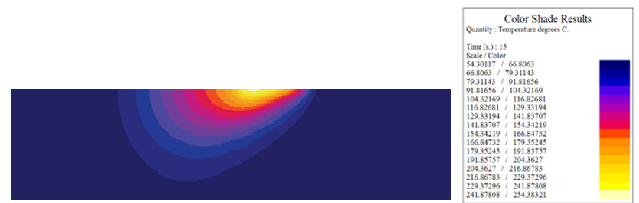
Figure 14. Temperature profile calculated by finite element simulation.